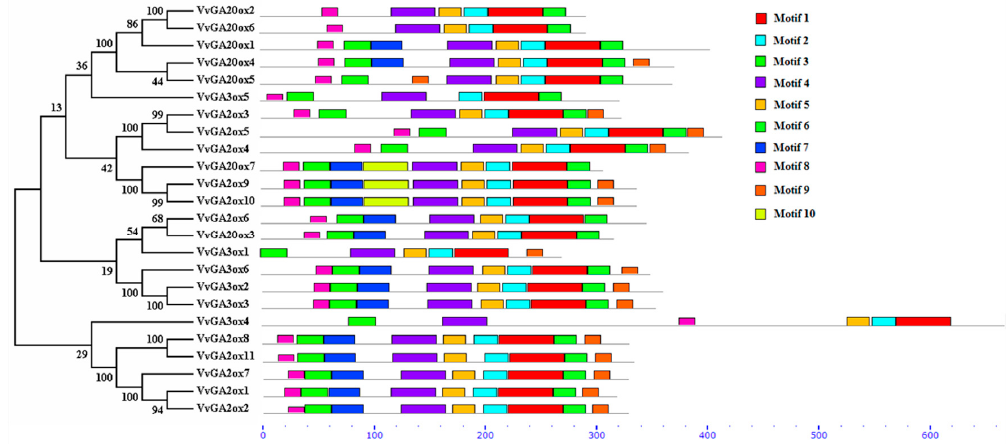
Figure 3. Schematic of the amino acid Motifs of GA2ox, GA3ox, and GA20ox proteins in grape